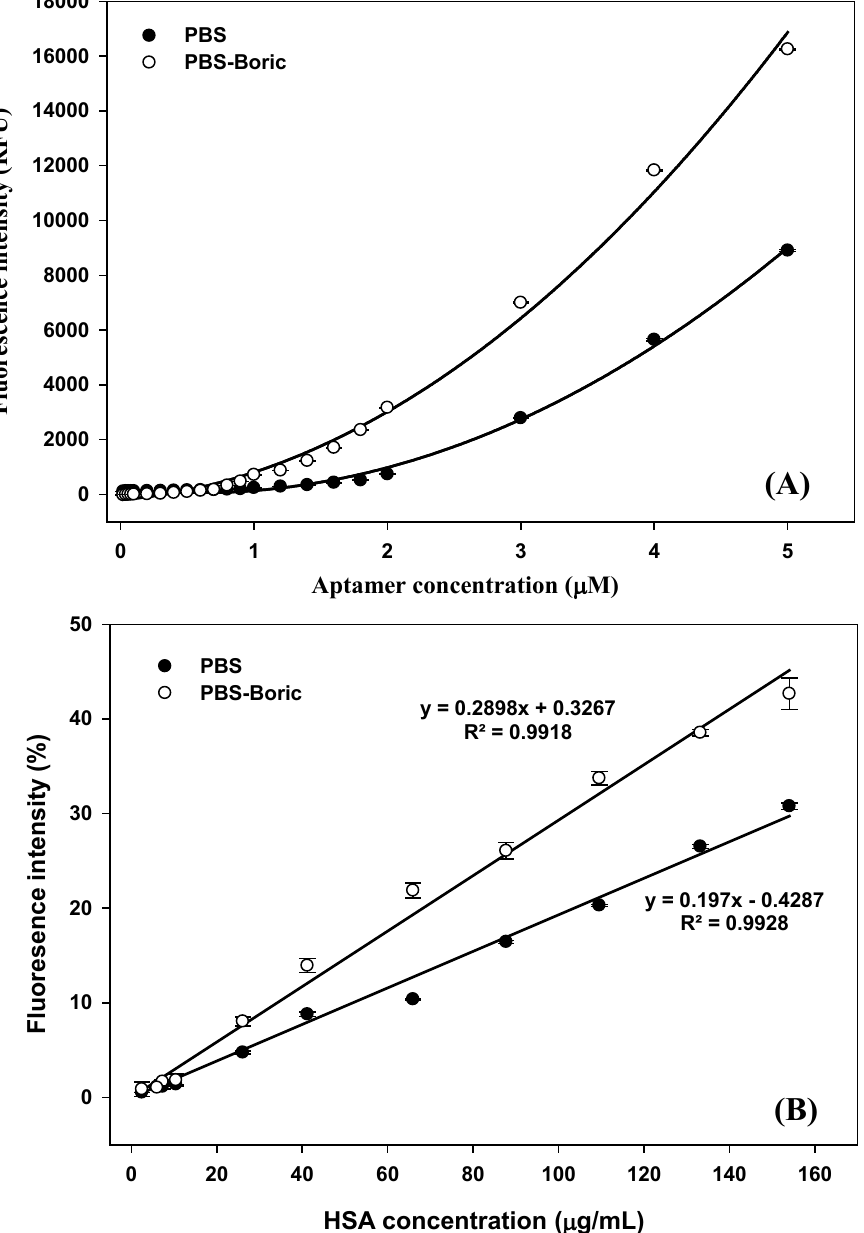
Figure 5. Fluorescence intensities of various concentrations of fluorescence-labeled H8 aptamer incubated with 5.0 mg/L GO in PBS buffer and PBS–boric buffer ( A ) and the calibration curve of fluorescence responses and HSA concentrations in PBS buffer and PBS–boric buffer determined using the developed aptasensor ( B ).